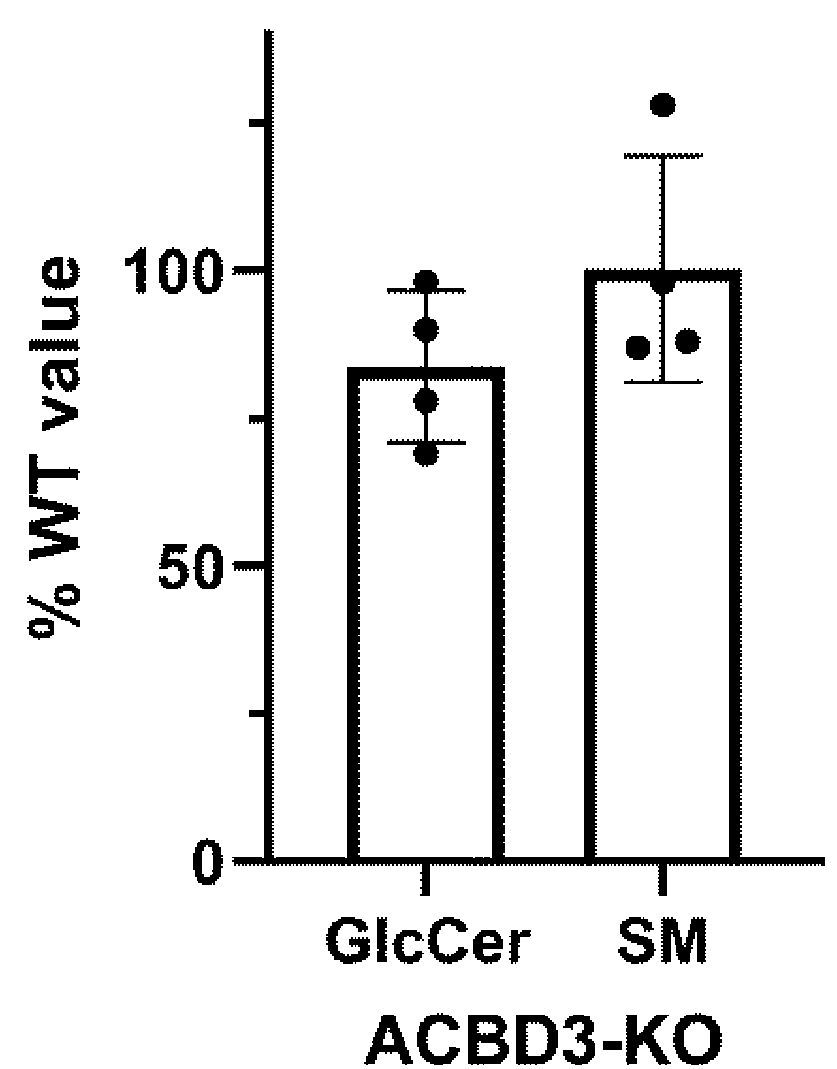
Figure A6. Quantification TLC results from Figure 5I. Relative signal intensity of glucosylceramide synthase (GlcCer) activity and sphingomyelin synthase (SM) activity were normalized to the intensity of ceramide by a densitometric analysis. Each dot represents value for particular ACBD3-KO. Values are displayed as a percentage of control value.